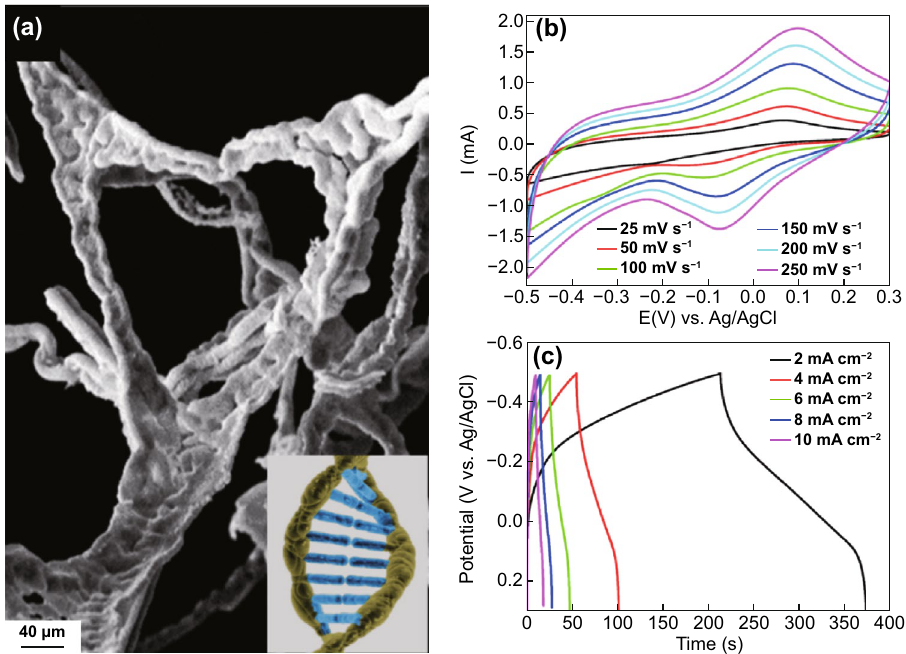
Fig. 14 a SEM image depicting DNA-like double helical tripodal microfiber superstructure along with representative DNA image shown in the inset for comparison. b Scan rate-dependent CV curves and c GCD curves at different current densities for DNA-like double helical WO 3–x